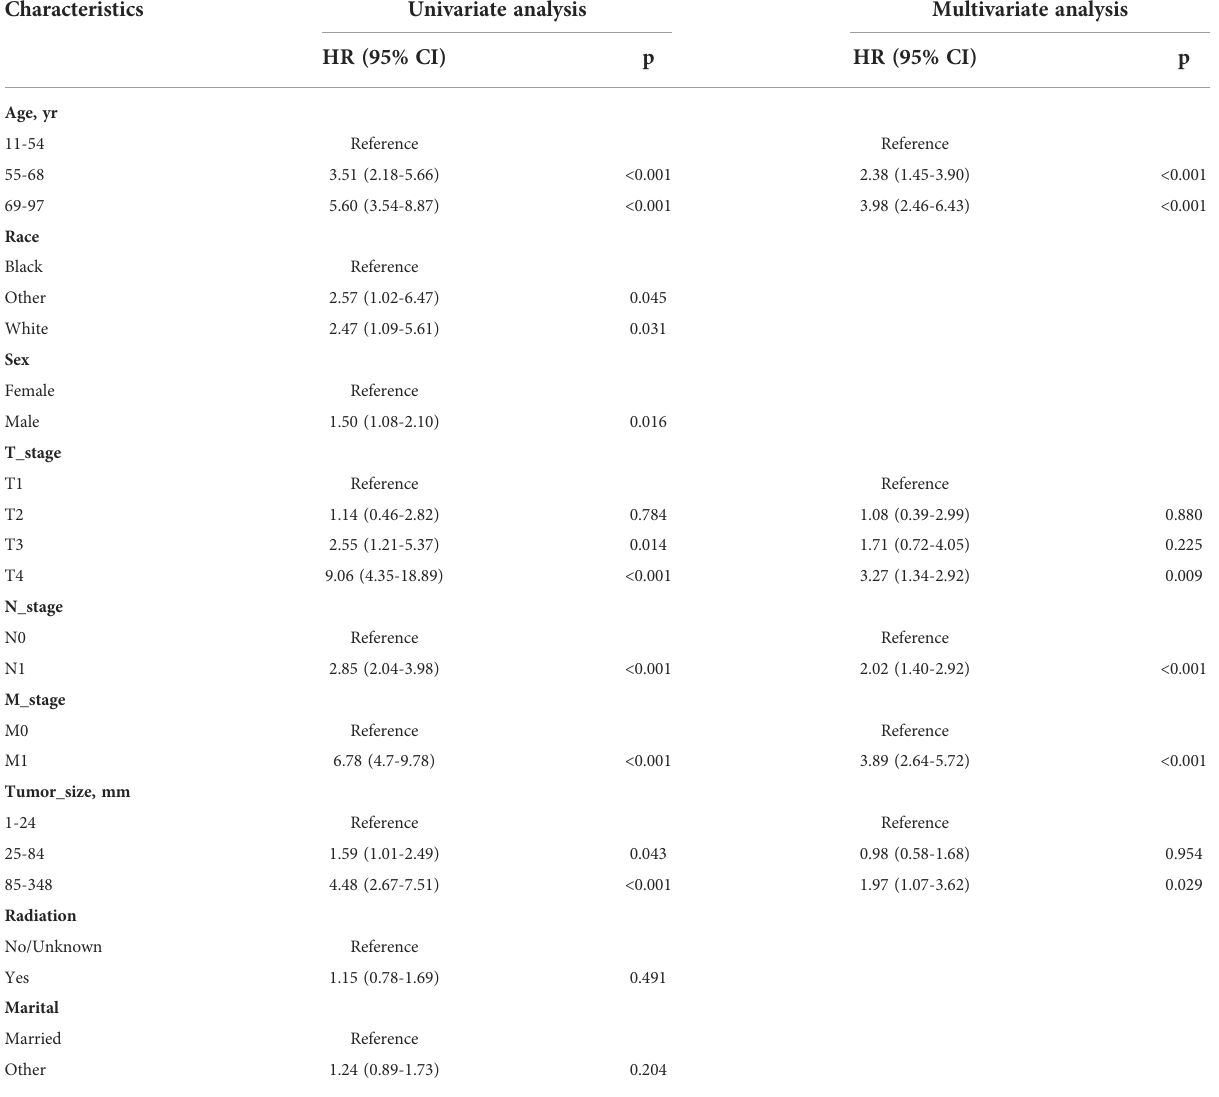
TABLE 2 Univariate and multivariate Cox regression analysis for PDTC CSS (Training Cohort).